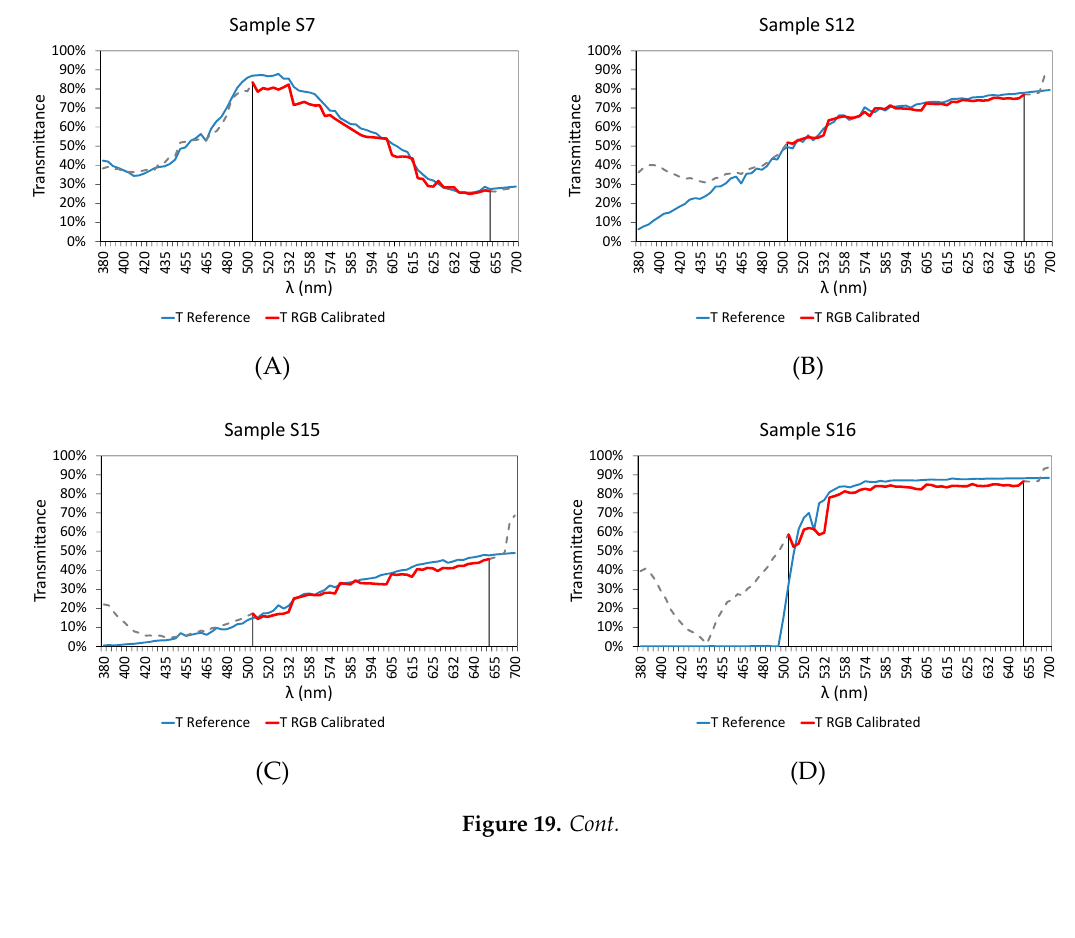
Figure 18. RGB-LED calibration between 380 and 700 nm for sample S4.